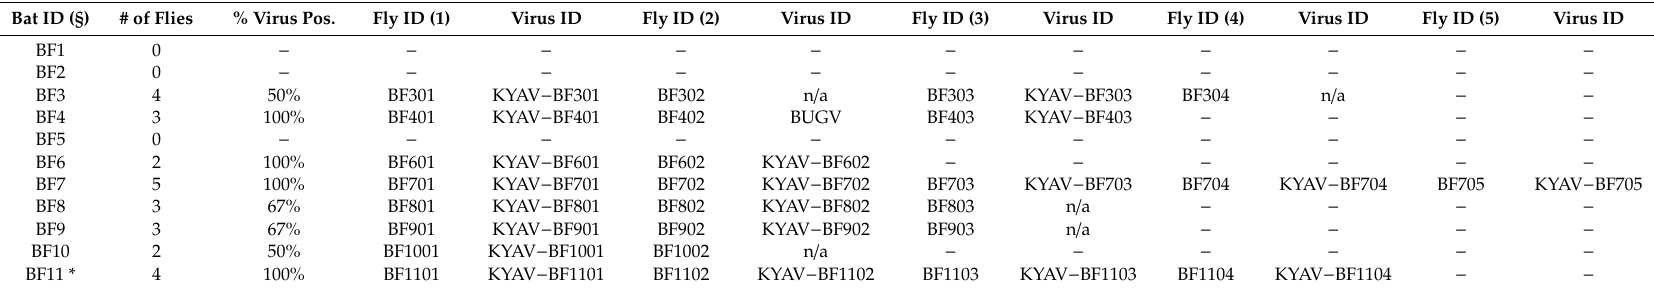
Table 1. Distribution of bat flies and associated ledantevirus isolates on bats. KYAV: Kanyawara virus; BUGV: Bughendera